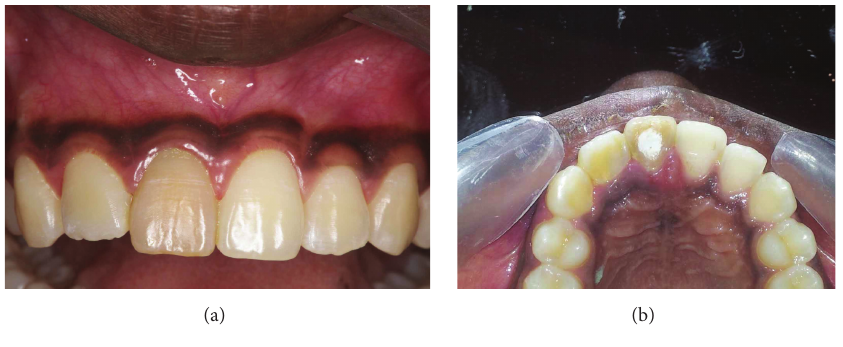
Figure 1: (a) Labial view. (b) Palatal